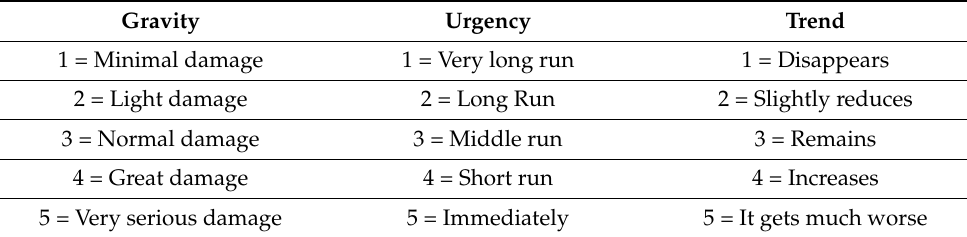
Table 3. GUT matrix model [24].